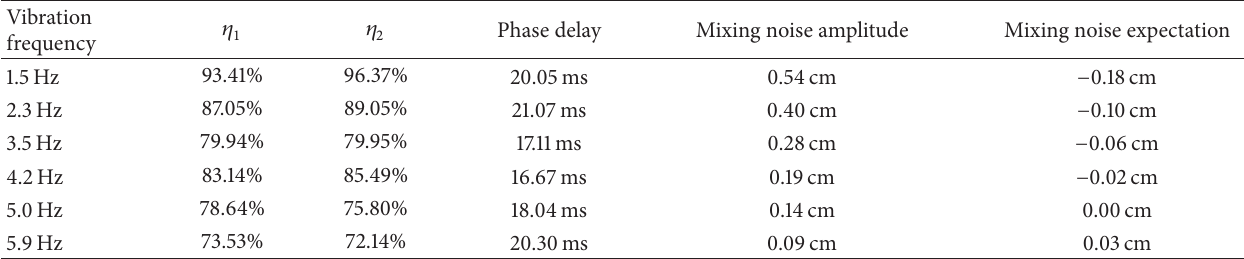
Table 2: Data error analysis of the reconstruction